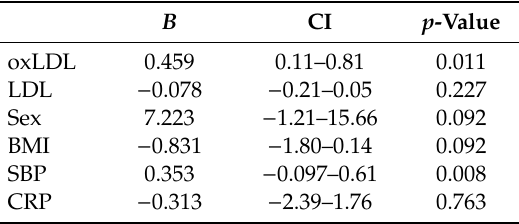
Figure 1. Serum biomarkers in a young population with and without previous cardiovascular disease. Serum levels of biomarkers in subjects with high-lifetime cardiovascular risk (LT-CVR), low-lifetime cardiovascular risk (LT-CVR) or stable coronary artery disease (SCAD). ( A ) C-reactive protein (CRP). ( B ) N-terminal pro-B-type natriuretic peptide (NT-proBNP). ( C ) Oxidized LDL (oxLDL). ( D ) Correlation analysis of oxLDL and NT-proBNP. * p < 0.05, ** p < 0.01, *** p < 0.001 versus low LT-CVR; # p < 0.05, ### p < 0.001 versus high LT-CVR. Table 2. Multivariate regression analysis of N-terminal pro-B-type natriuretic peptide, oxidized low-density lipoprotein, traditional cardiovascular risk factors and C-reactive